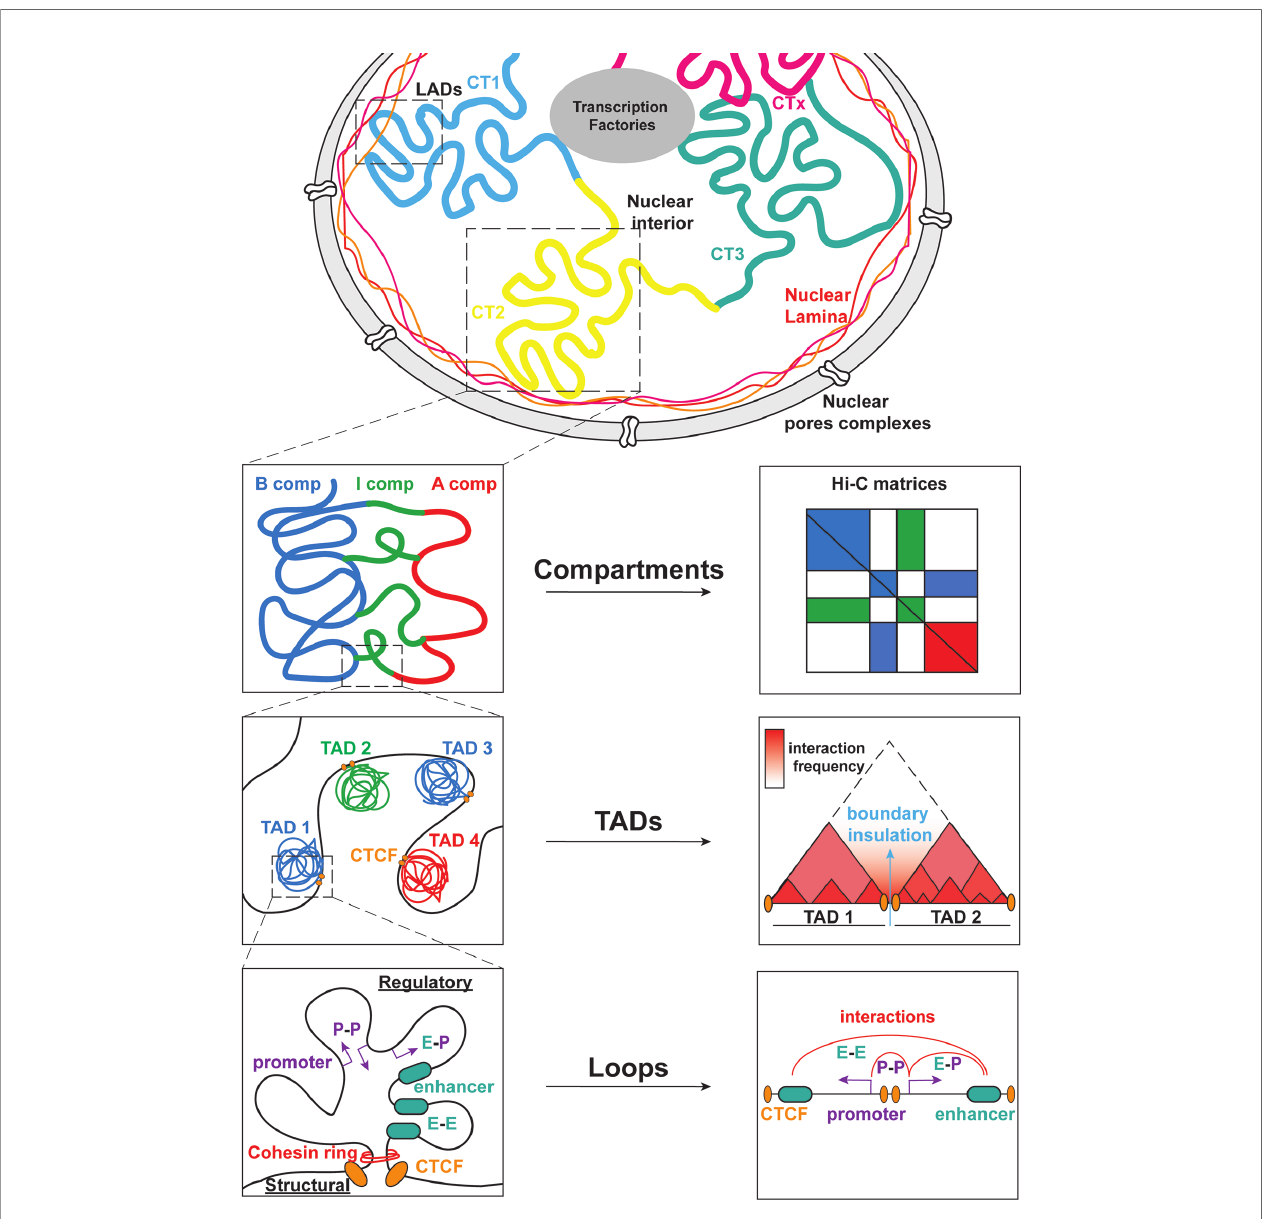
FIGURE 2 | Global genome organization in mammalian nuclei from the megabase scale to the E-P level. Mammalian nuclei are organized into chromosomes with non-random distribution in the nucleoplasm. Each chromosome is further composed of chromosome territories (CT) further subdivided into A/B/I compartments. Within these compartments, TADs allow for interactions between regulatory elements (RE) that modulate gene expression. The cis / trans interactions take place between promoters (P-P), enhancers (E-E) or both